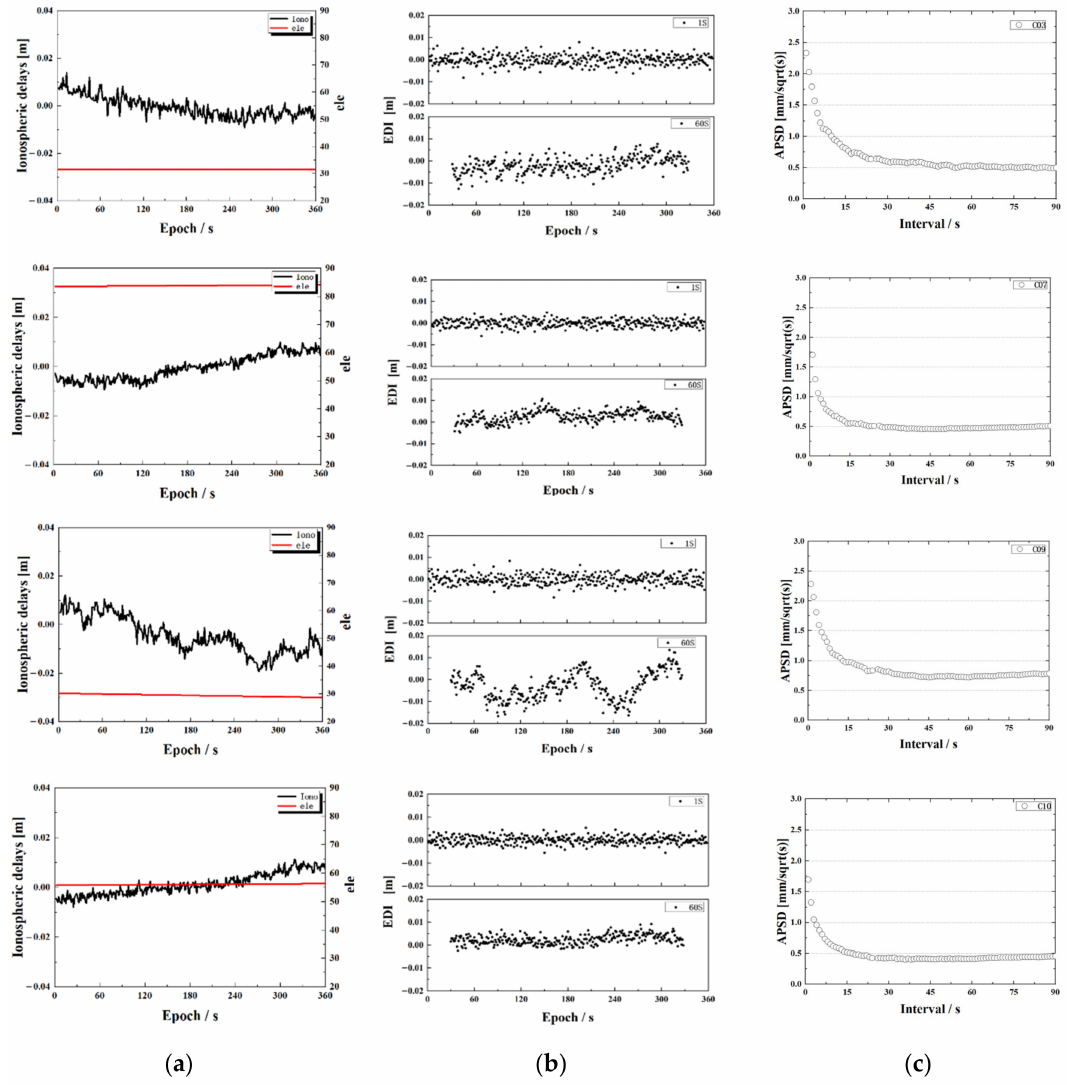
Figure 2. Time series of satellite ionospheric delays ( a ), the EDI at a differential interval of 1 s and 60 s ( b ), and APSD obtained at a different differential interval ( c ) for satellite C03, C07, C09 and C10 (from top to bottom) of the long-range baseline of 202 km. The sampling rate of the observations is 1